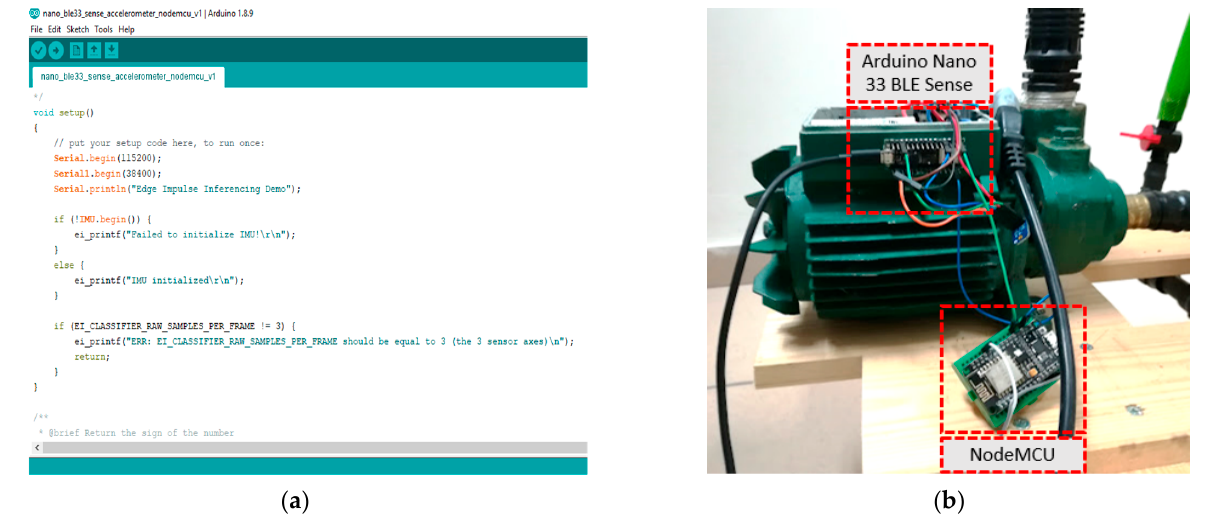
Figure 5. ( a ) The Arduino IDE environment utilized for porting the trained neural network model onto the microcontroller and further code customization options. ( b ) Details of the 2-MCU design of the on-device intelligence solution utilizing an Arduino Nano 33 BLE Sense unit and a NodeMCU